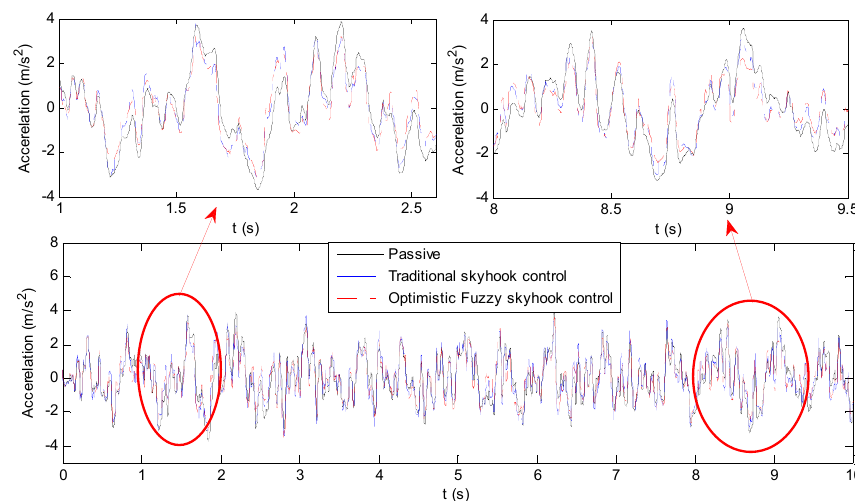
Figure 16. Comparison of the body vertical acceleration of the three control methods under C class road excitation.